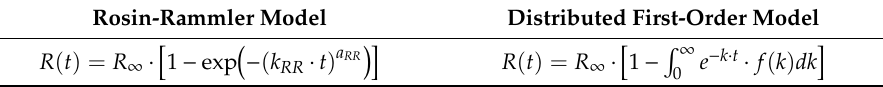
Figure 4. Examples of estimated f ( k )s and model fitting, size-by-size Cu results; ( a ) First-order f ( k )s, Equation (12), ( b ) Time-recovery data, continuous curves obtained by fitting the R ( t ) model of Table 4, ( c ) Second-order f ( k )s, Rectangular distributions. Table 5. Rosin–Rammler model versus its first-order